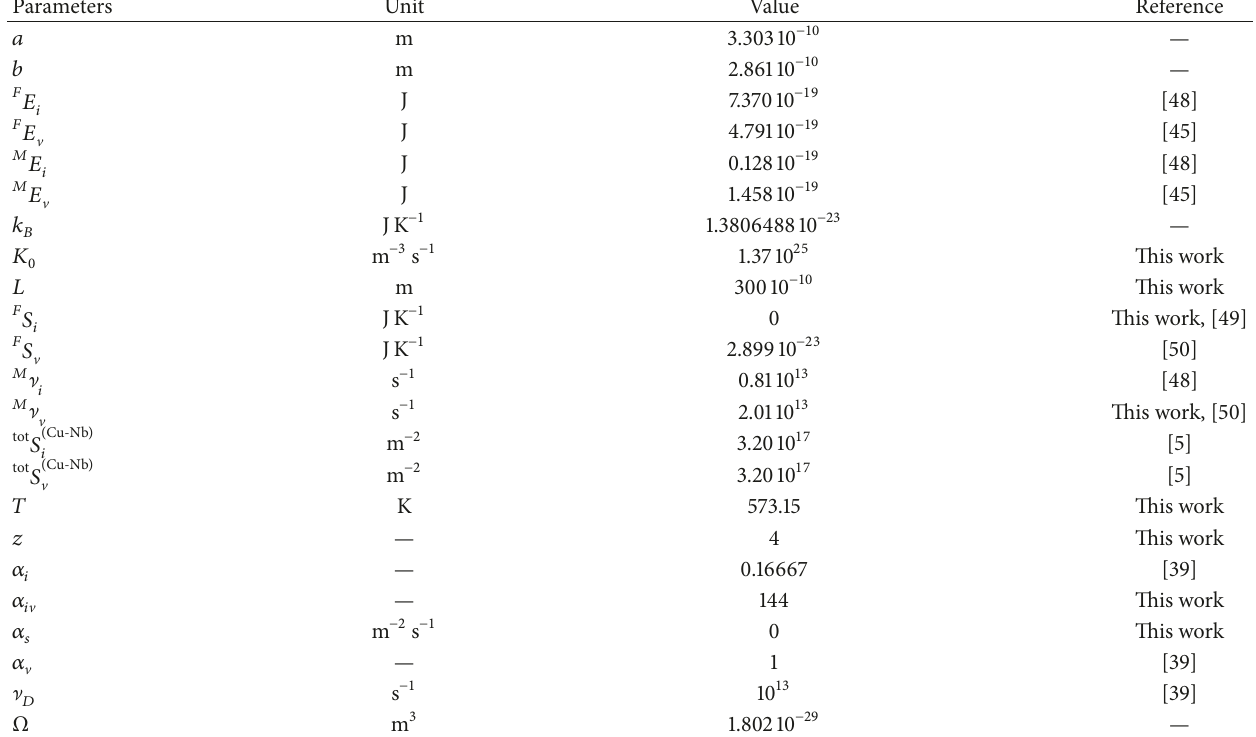
Table 3: Model parameters for